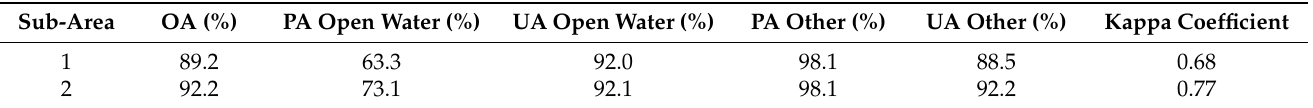
Table 3. Statistical evaluation of comparison between flood extent detected by the developed solution and digitized from a PlanetScope image for the Czech Republic, autumn 2020 flood